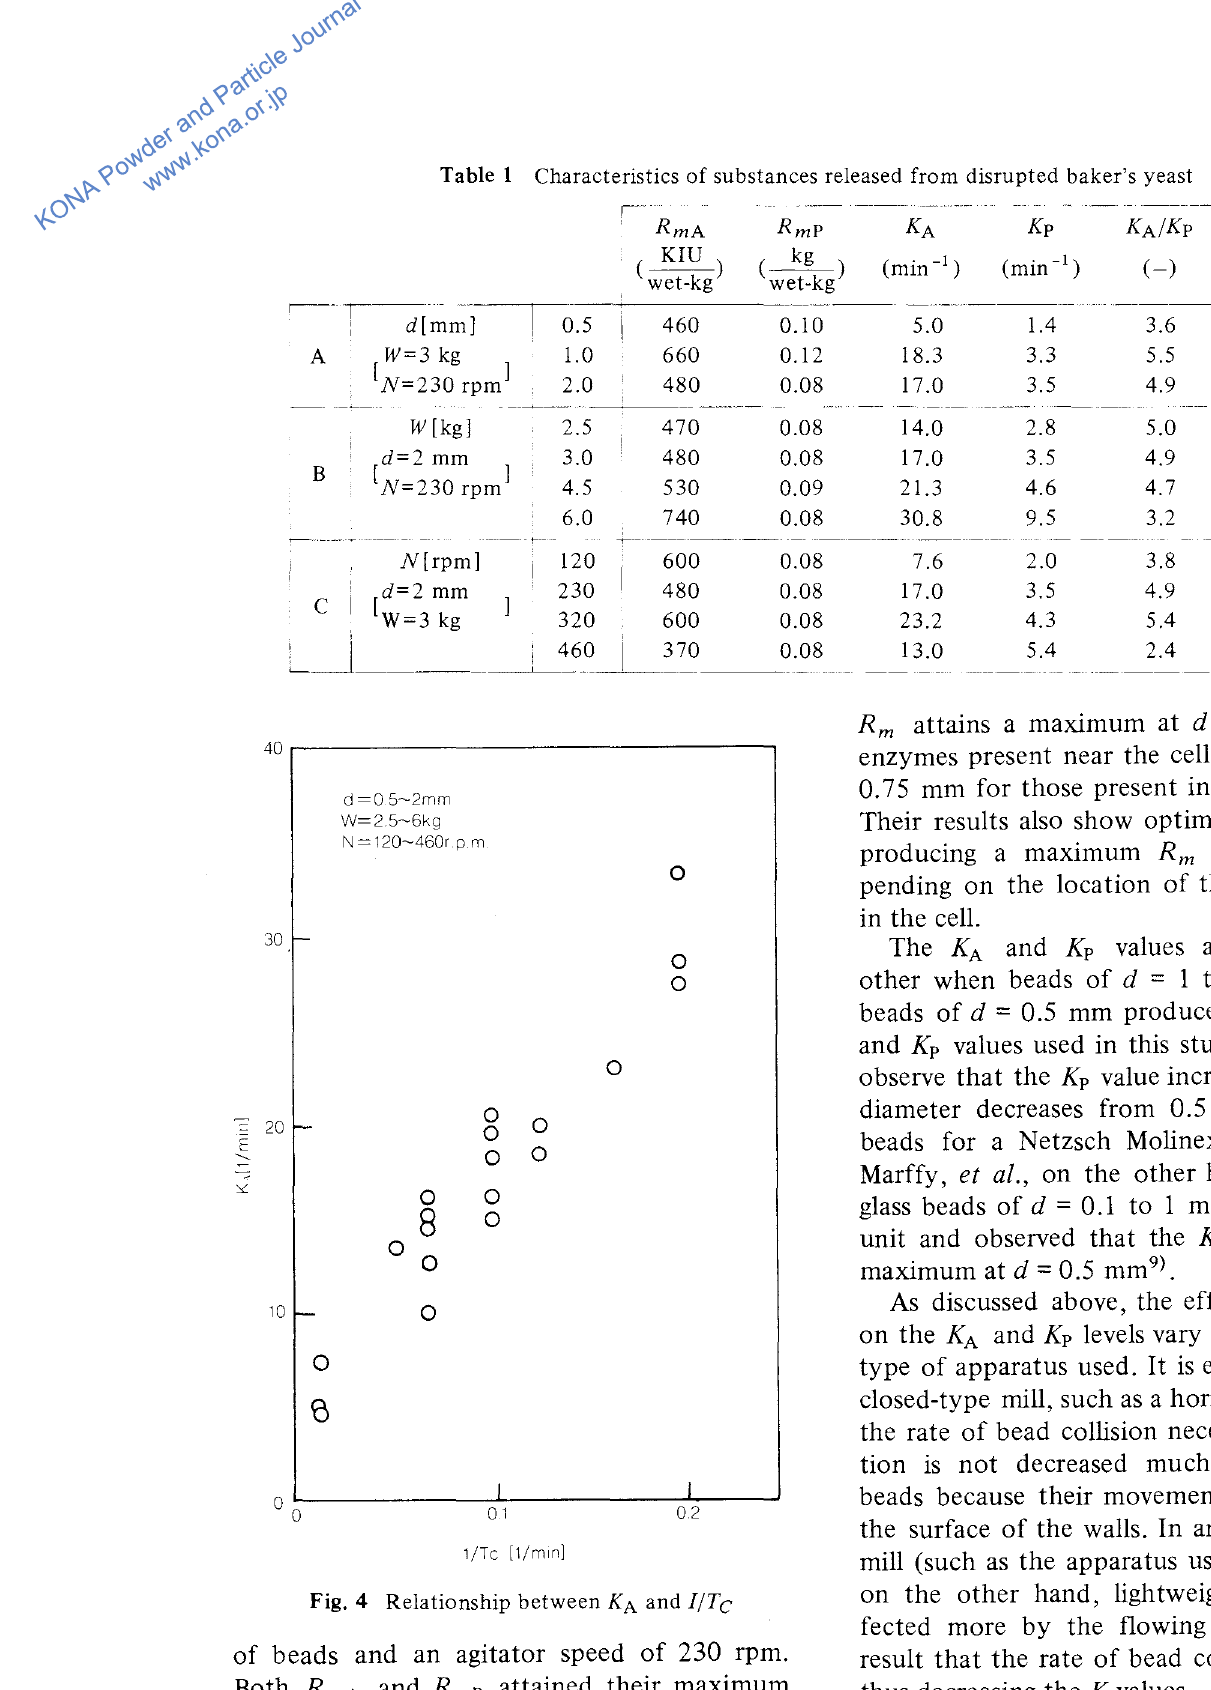
Fig. 4 Relationship between KA and